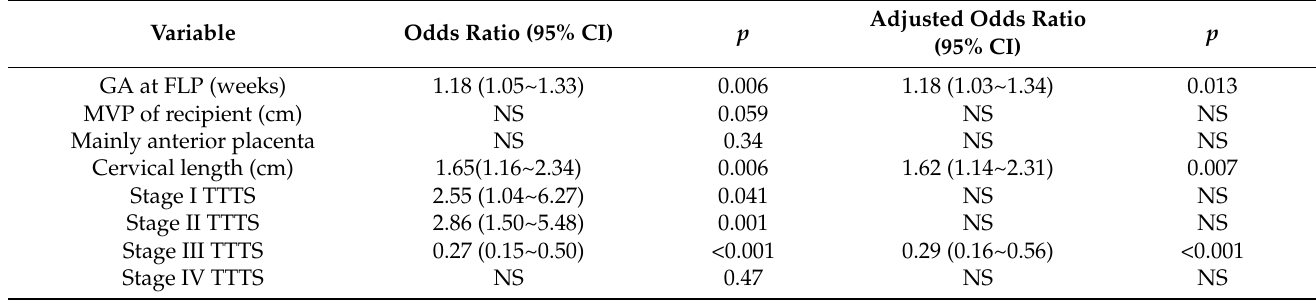
Table 5. Antenatal variables for the survival of both twins after FLP in severe cases of TTTS.